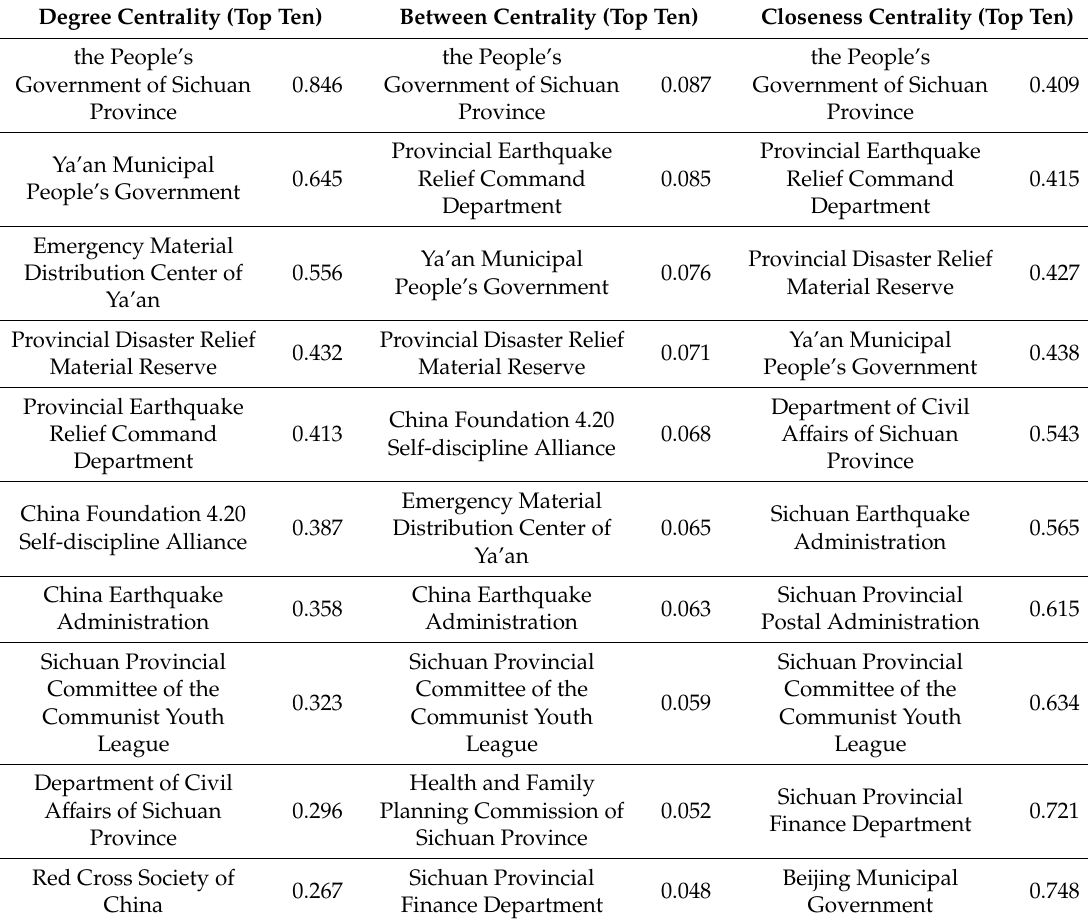
Table 3. The measure values of the actual response organization